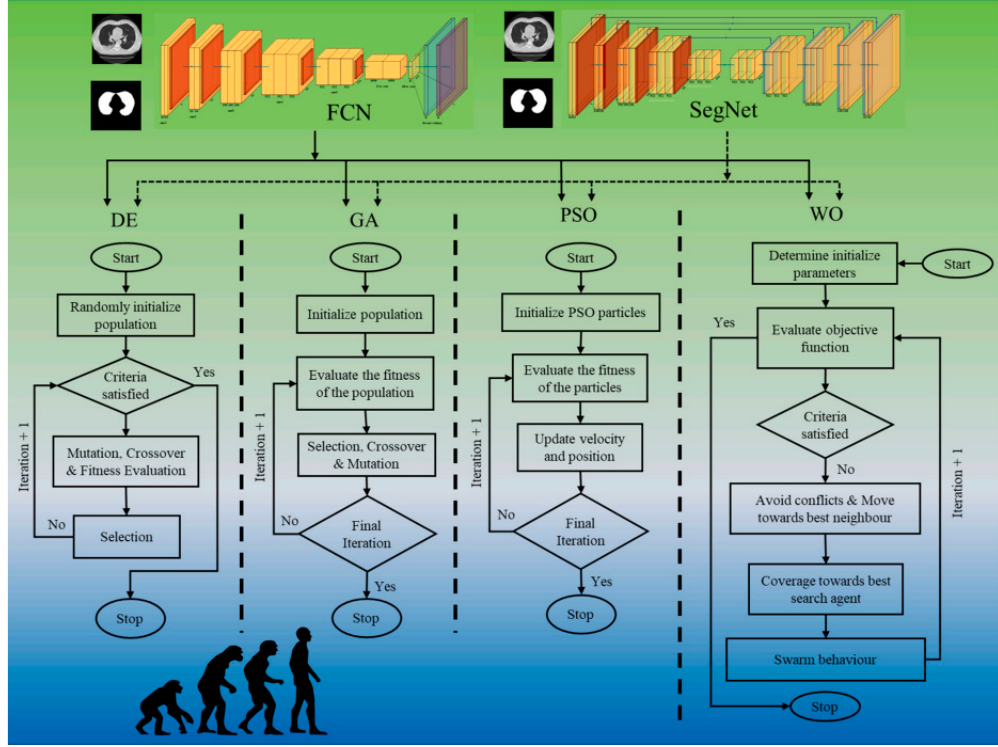
Figure 17. Eight systems were created using four pruning approaches (DE, GA, PSO, and WO): FCN ‐ DE, FCN ‐ GA, FCN ‐ PSO, FCN ‐ WO and SegNet ‐ DE, SegNet ‐ GA, SegNet ‐ PSO, and SegNet ‐ WO